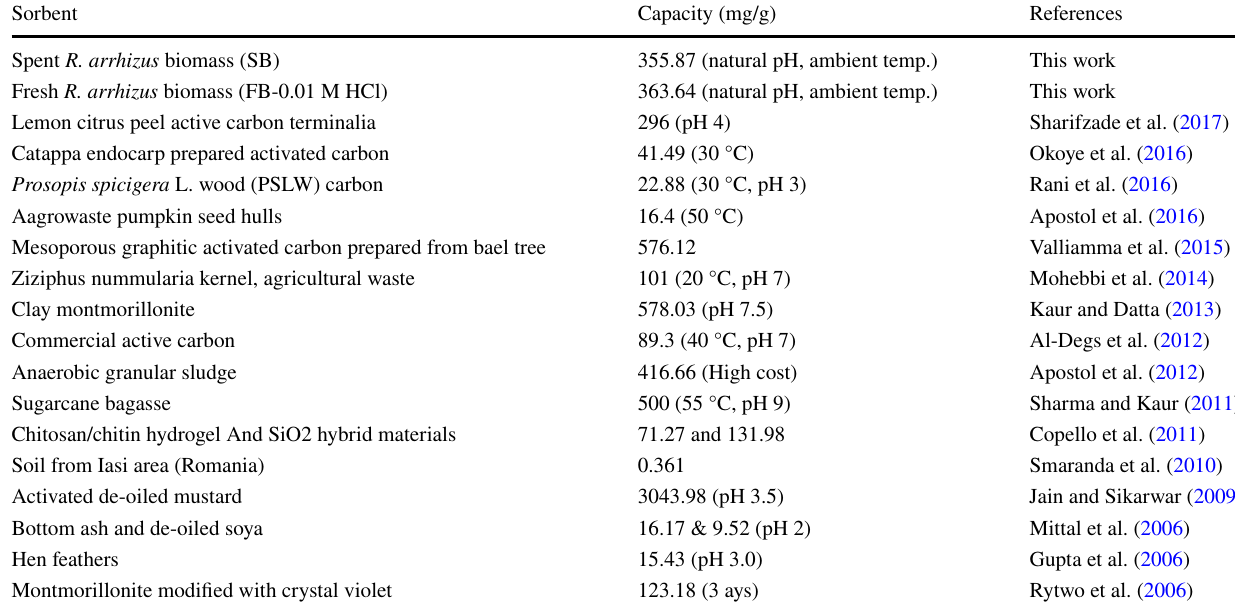
Table 3 Adsorption capacities of other sorbents reported in the literature for dye EB removal